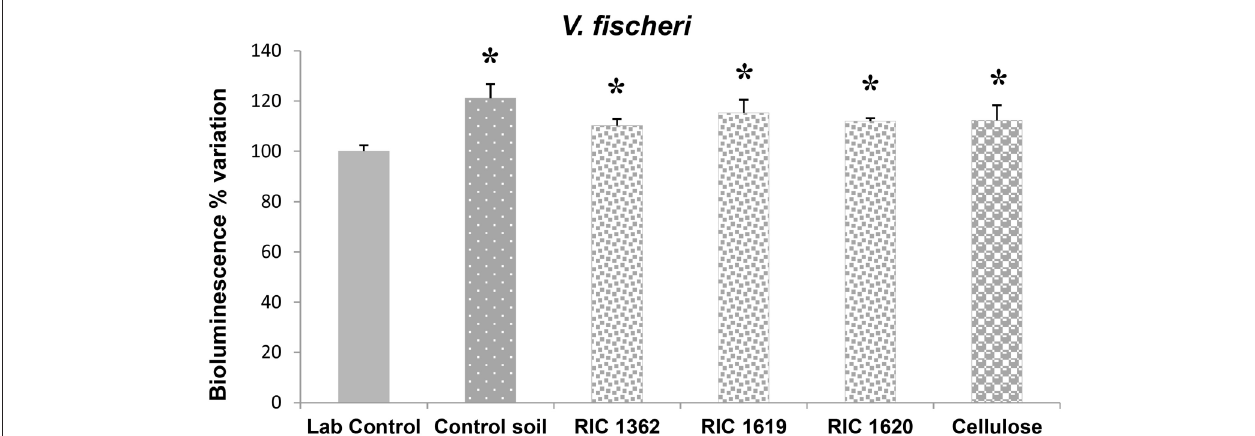
FIGURE 1 | Light emission of V. fischeri after exposure to the elutriate samples. Data are expressed as % variation with respect to lab control and represent the mean ± SD of at least five replicates. *Indicates statistically significant differences with respect to lab control values ( p < 0.05 Mann–Whitney U -test). RIC 1362, RIC 1619, RIC 1620, Mater-Bi soils; Cellulose, soil containing cellulose reference material.